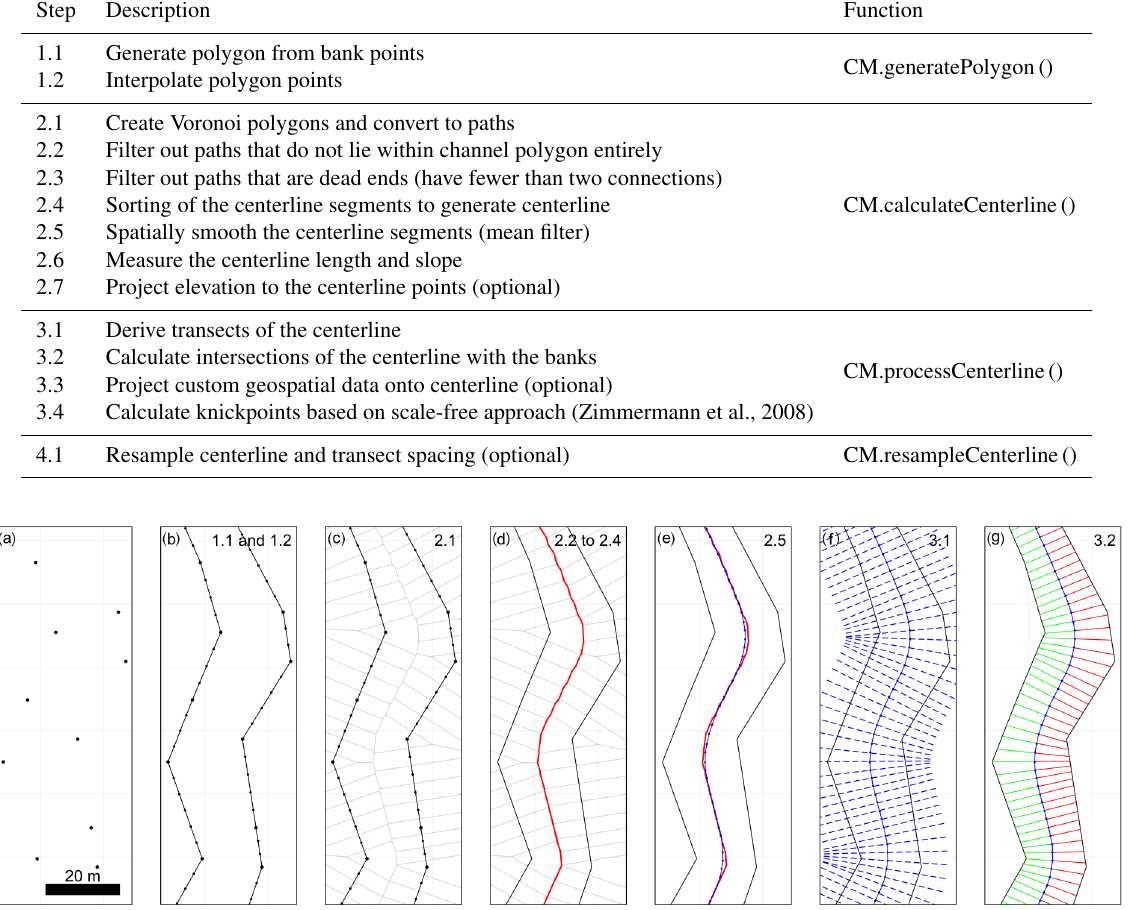
Figure 1. Visualization of the work flow of the package. (a) The channel bank points represent the data input. (b) A polygon is generated where bank points are linearly interpolated, (c, d) the centerline is calculated via Voronoi polygons, (e) the centerline is spatially smoothed with a mean filter, (f) transects are calculated, (g) and the channel width is derived from the